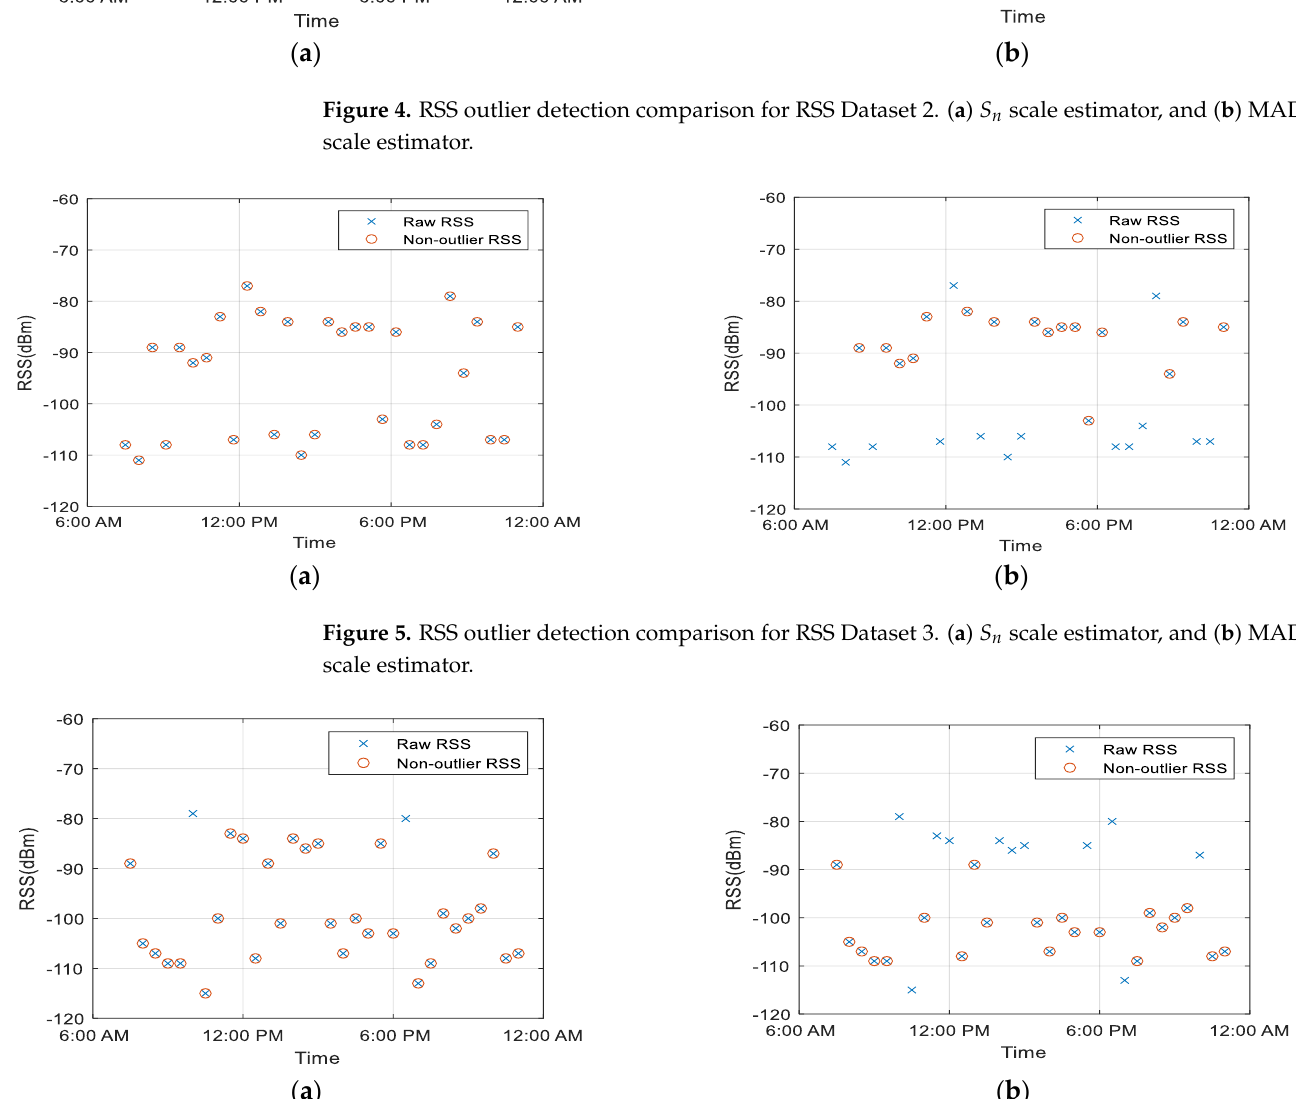
( b ) Figure 7. RSS outlier detection comparison for RSS Dataset 5. ( a ) 𝑆 𝑛 scale estimator, and ( b ) MAD scale estimator. ( a ) ( b ) Figure 8 . RSS outlier detection comparison for RSS Dataset 6. ( a ) 𝑆 𝑛 scale estimator, and ( b ) MAD scale estimator.